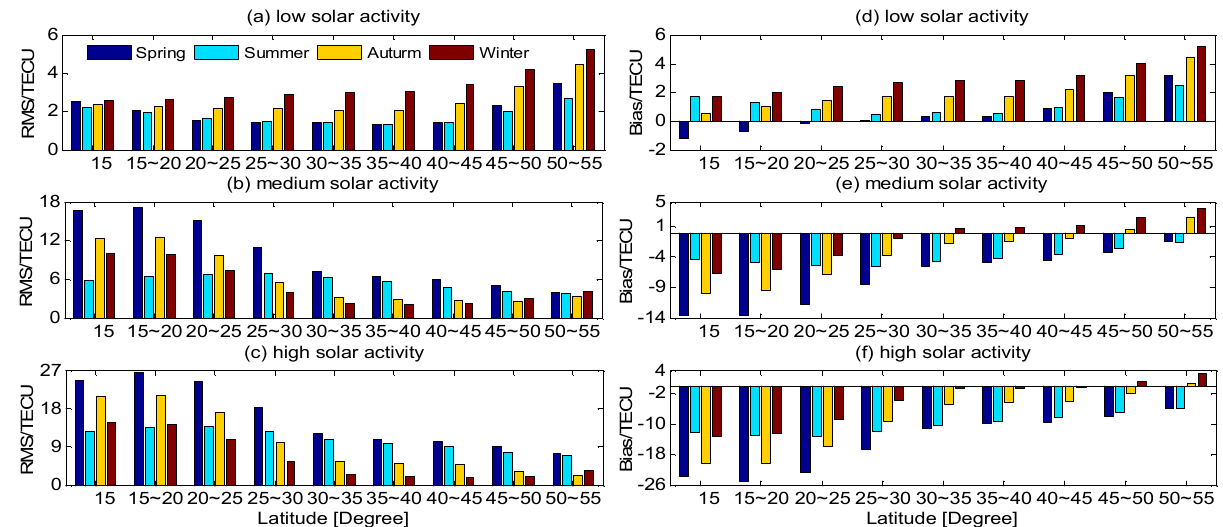
Fig.5 Season average Bias and RMS of Klobuchar model during high, medium and low solar activities